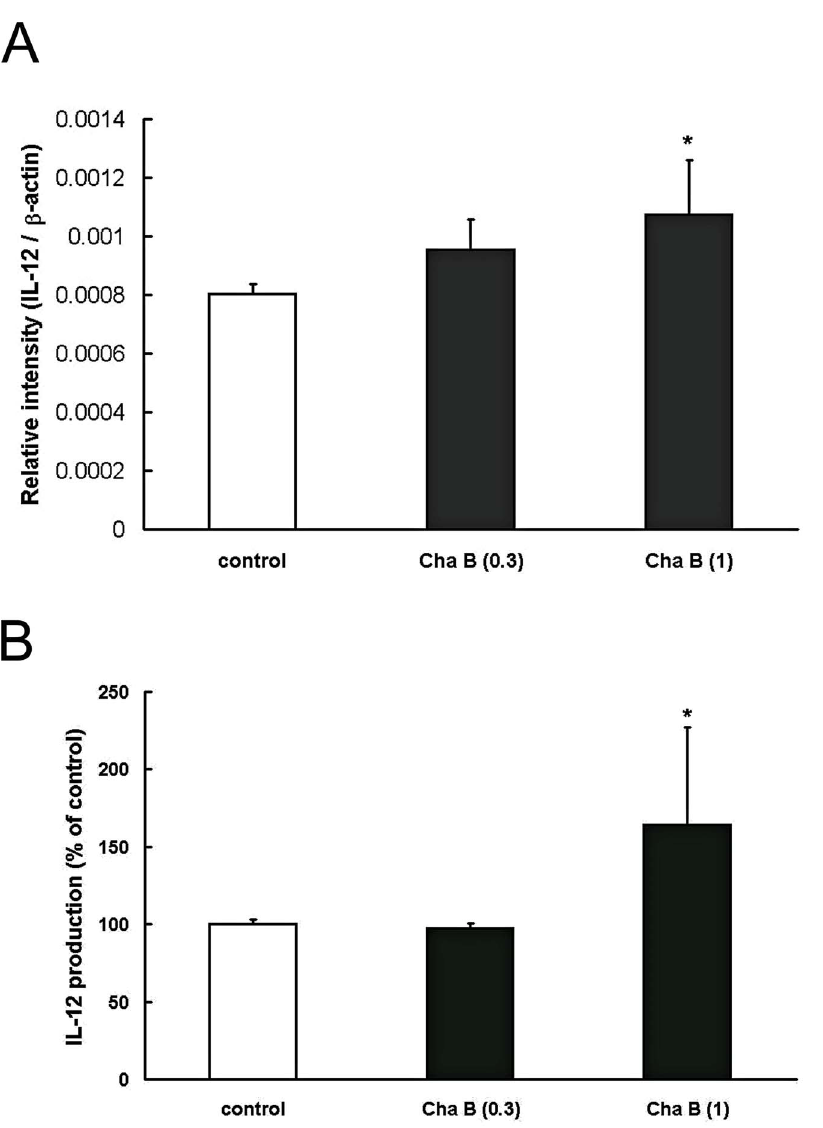
Figure 3. Chafuroside B enhanced IL-12 mRNA expression and production in human keratinocytes. A NHEK were treated with chafuroside B (0.3 and 1 m M). The cells were harvested after 3 h and IL-12 mRNA was quantitated by means of RT-PCR. B NHEK were treated with chafuroside B (0.3 and 1 m M). After 72 h, supernatants were collected and IL-12 was evaluated by means of ELISA. Cha B = Chafuroside B. All data are expressed as the mean 6 SD ( n =3 or 4). * P , 0.05 compared with the